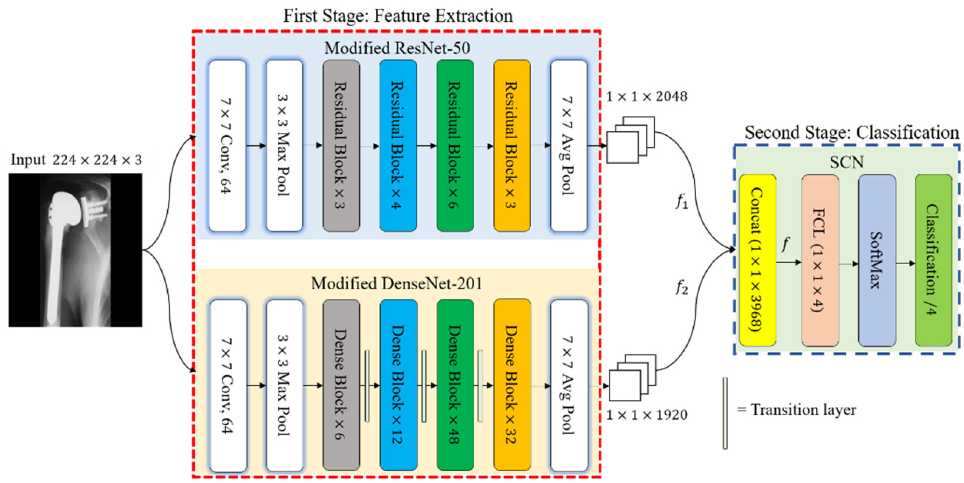
Figure 4. Diagram of our proposed DRE-Net for feature extraction and